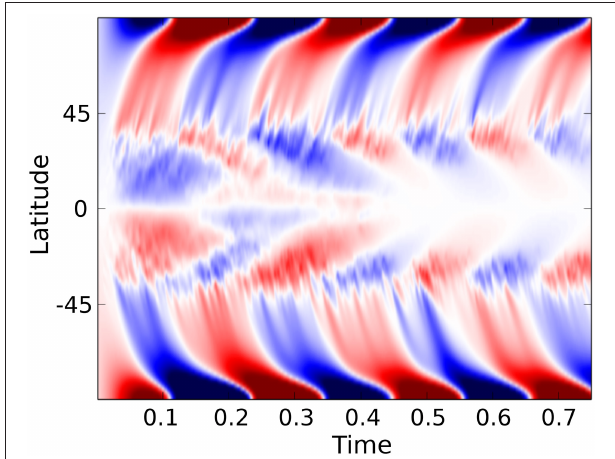
FIGURE 6 | Butterfly diagram for the mean radial magnetic field ( Br ) at the surface showing field reversals. The horizontal axis represents the magnetic diffusion